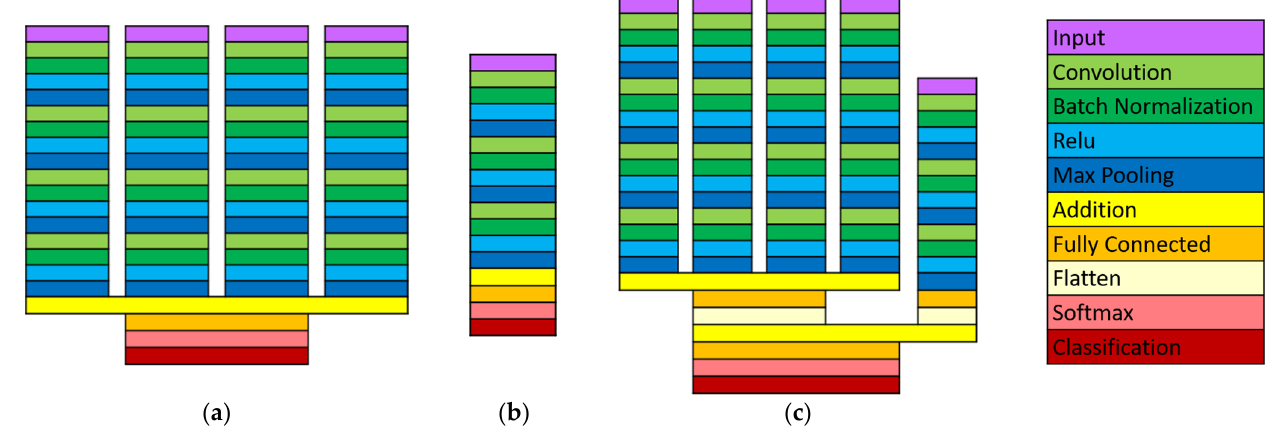
Figure 3. Classifier algorithm architecture: ( a ) Sonomyography spatial–temporal convolutional network. ( b ) Kinematic temporal convolutional network. ( c ) Combined sonomyography and kinematic network.